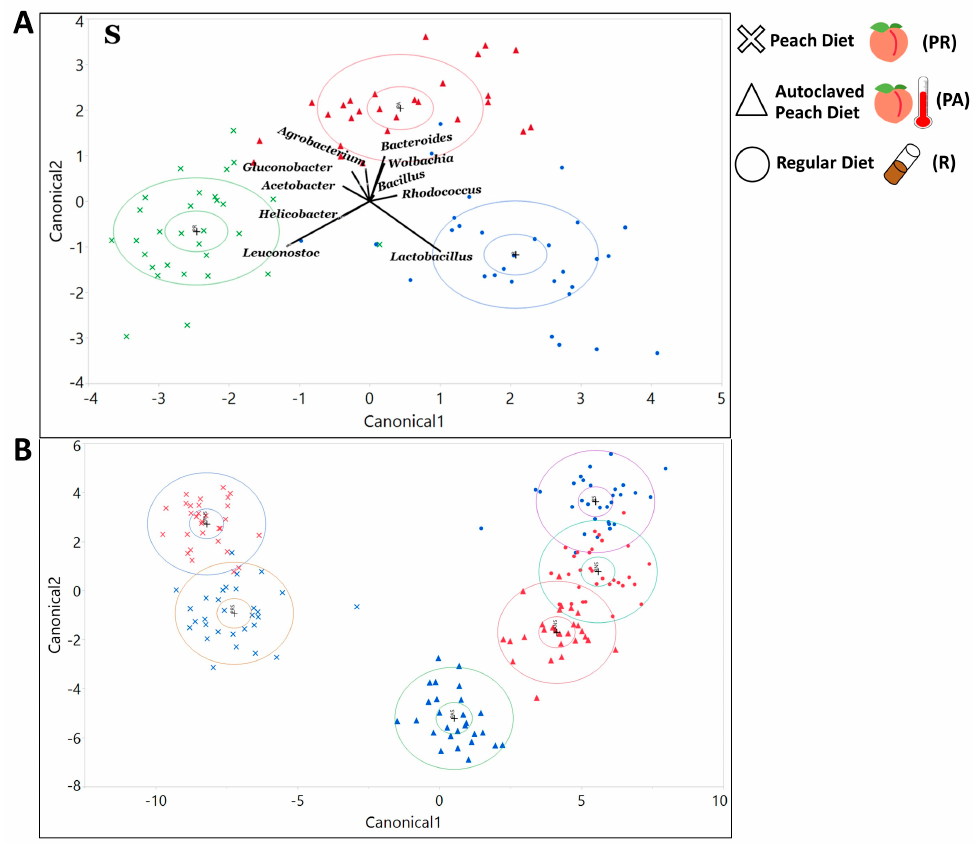
Figure 3. Microbial communities of the larvae raised on all of the diets could be differentiated by the abundance of dominant bacteria taxa. Discriminant analysis of symbiotic bacterial community based on taxa relative abundances in larvae. ( A ) The 10 most abundant bacterial genera found in sterilized larvae. Diet serves as a good predictor for bacterial communities differentiation. The length of the vector is correlated with the strength of the impact that it produced for the samples to be separated, in the vector direction, on the canonical plot. ( B ) The 100 most abundant ZOTU found in larvae. All diets and treatments (non-sterilized red and sterilized blue) form distinct communities, with the PR raised larvae being the most different from larvae raised on other diets.